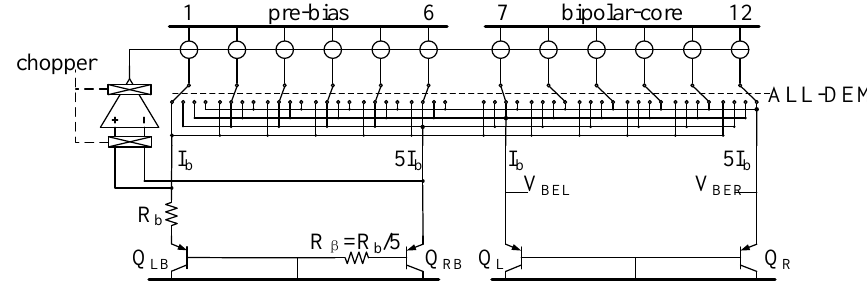
Figure 3. Front-end circuit employing the all dynamic element matching (ALL-DEM) approach.